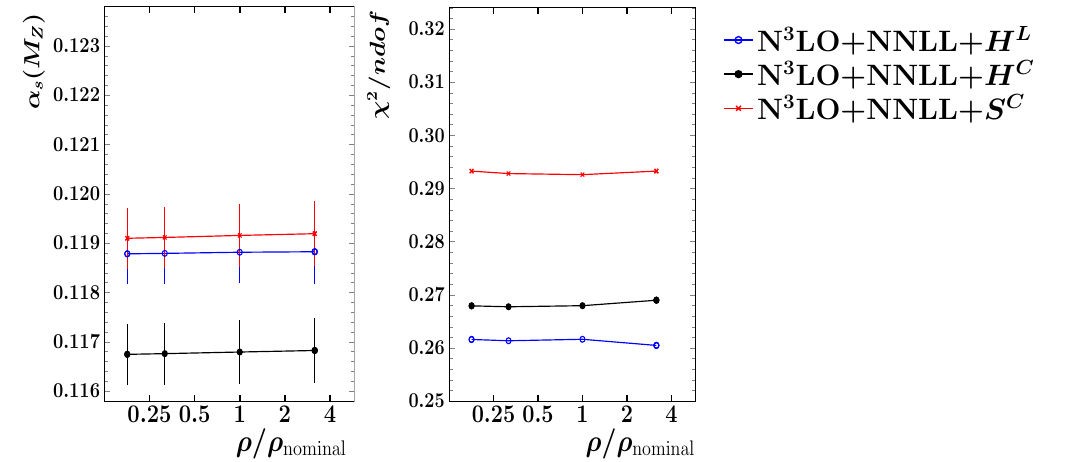
Figure 6 . Dependence of the ( R 2 ) (cid:12)t results on the parameter (cid:26) used in the correlation model. The (cid:12)t range is (cid:12)xed to [ (cid:0) 2 : 25 + L ; (cid:0) 1]. The result